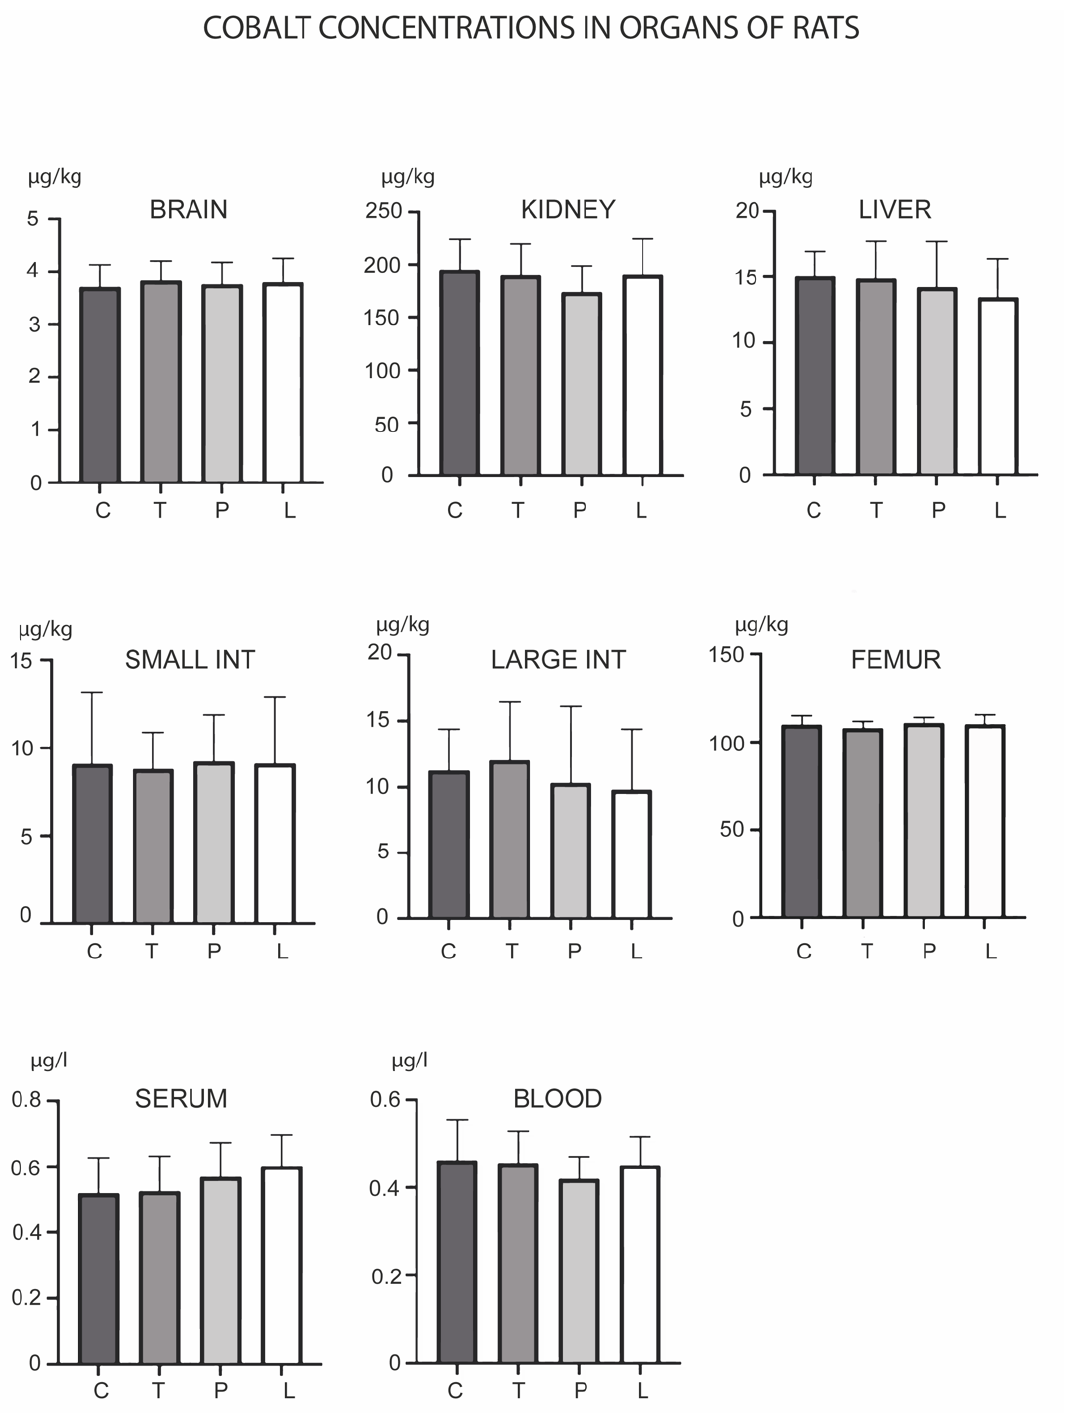
Figure 4. Concentrations of cobalt in the brain, kidney, liver, small intestine, large intestine, serum, blood and femur after the three-month oral administration of silicates. C denotes the control group; T denotes the experimental group receiving TMAZ; P denotes the experimental group receiving PMA; and L denotes the experimental group receiving Ludox silica. Asterisk (*) denotes significant differences between the experimental groups, with control at p < 0.05.